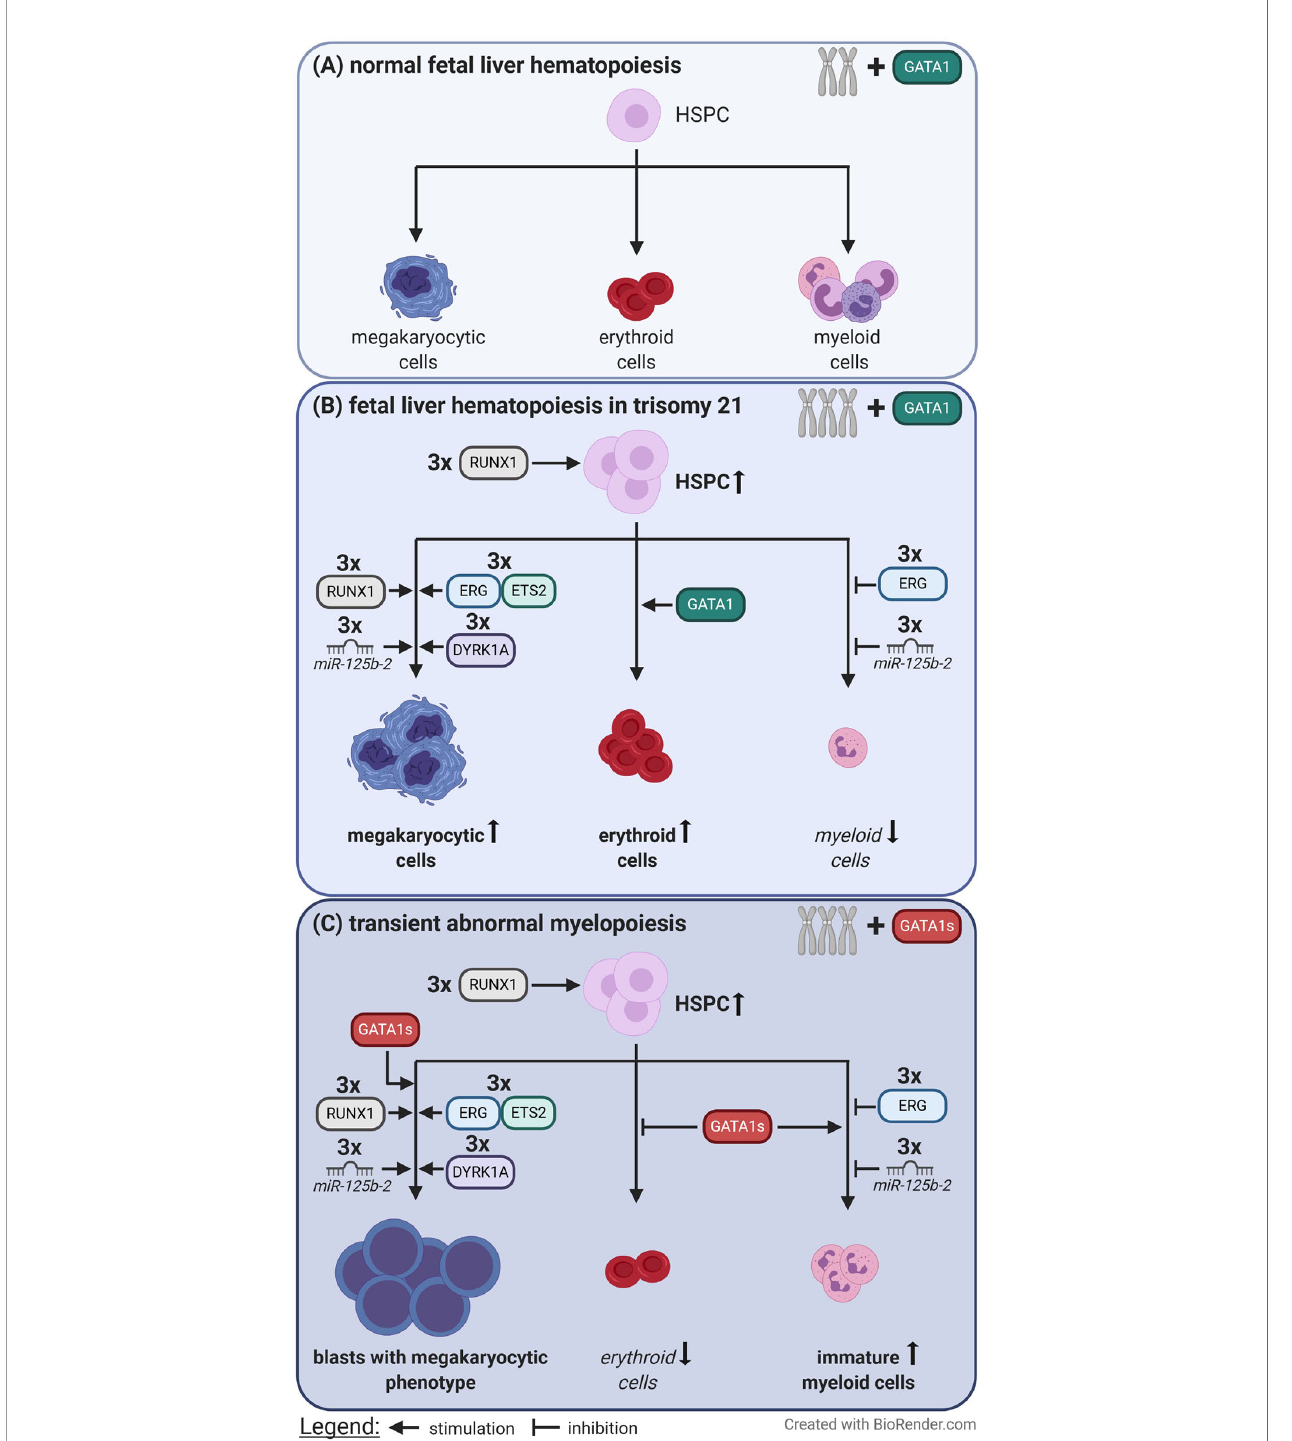
FIGURE 2 | Perturbation of fetal liver hematopoiesis caused by trisomy 21 and loss of full length GATA1. (A) In euploid individuals the balanced gene dosages of chromosome 21 and the presence of full length GATA1 contribute to normal fetal liver hematopoiesis. (B) In contrast trisomy 21 causes expansion of hematopoietic stem and progenitor cells (HSPC), megakaryocytic and erythroid cells via increased gene dosages. (C) When an additional GATA1 mutation, which leads to the expression of only the short isoform of GATA1 (GATA1s), is acquired immortalized megakaryocytic blasts rapidly expand at the expense of erythropoiesis. This is known as transient abnormal myelopoiesis which typically originates during fetal liver